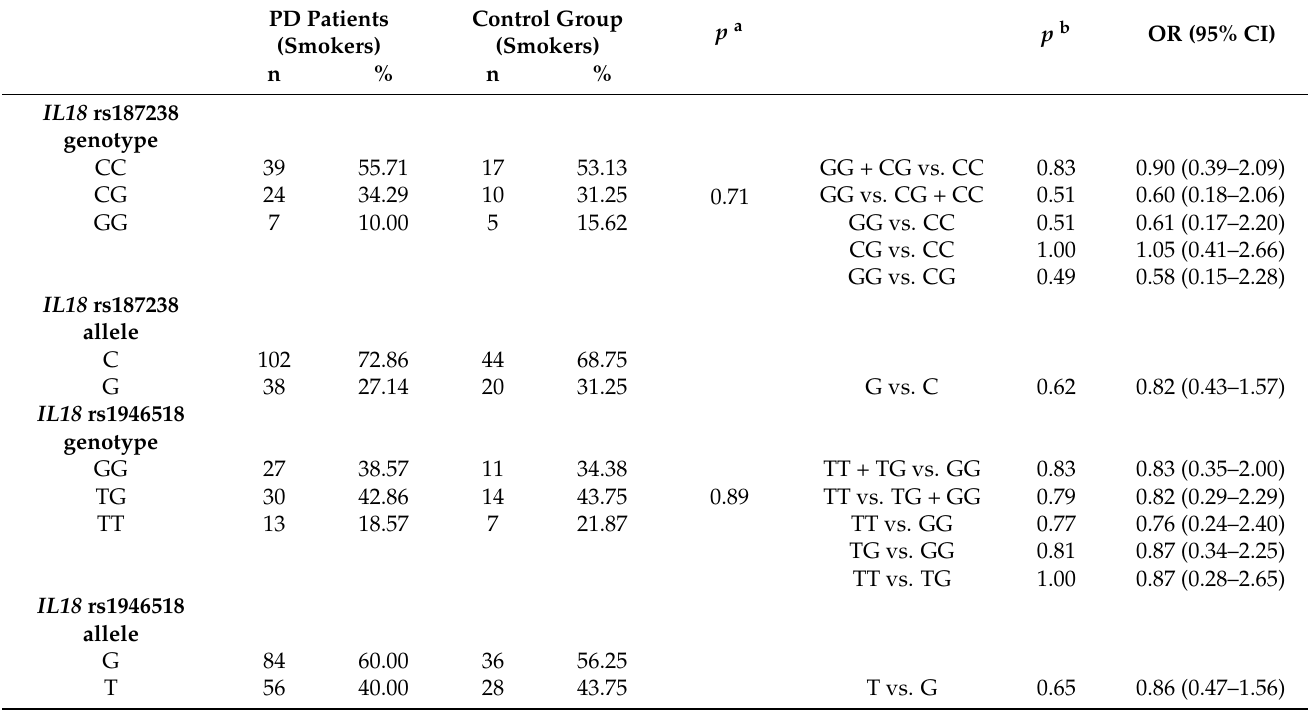
Table 4. The distribution of the IL-18 rs187238 and rs1946518 genotypes in periodontitis patients (PD patients) and the controls in the smoker group.